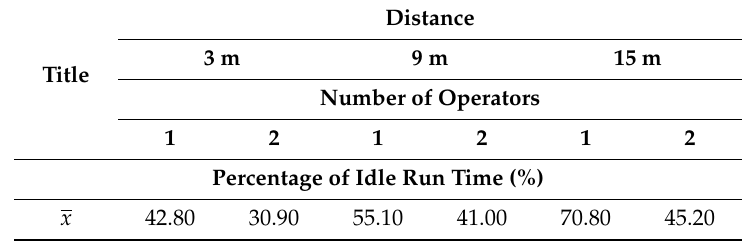
Figure 5. A ratio of the chipper idle run time to the number of operators and the distance of the pile of branches to the chipper; A—for one operator, B—for two operators, C—range of idle run time reduction due to increased number of operators to two.